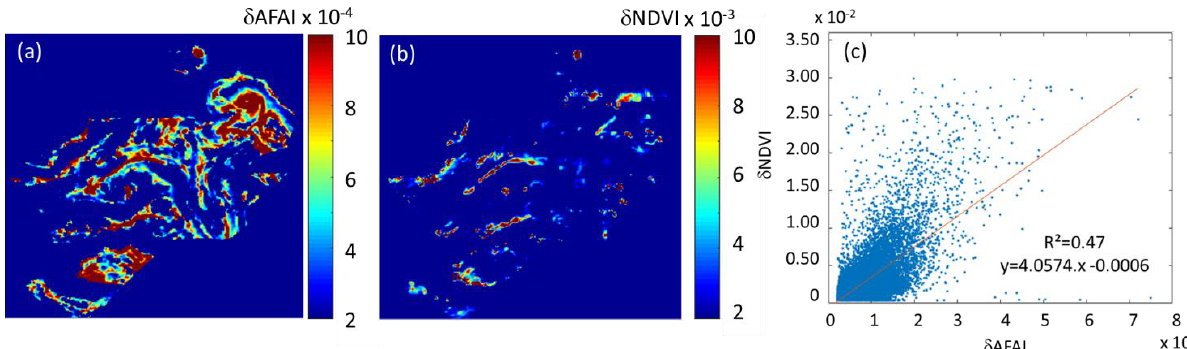
Figure 7. ( a ) Sargassum identification using MODIS ( δ AFAI >1.79 10 − 4 ), ( b ) GOES ( δ NDVI > 0.003), and ( c ) the 2D scatterplot δ NDVI = f( δ AFAI), over the δ AFAI > 1.79 × 10 − 4 range.